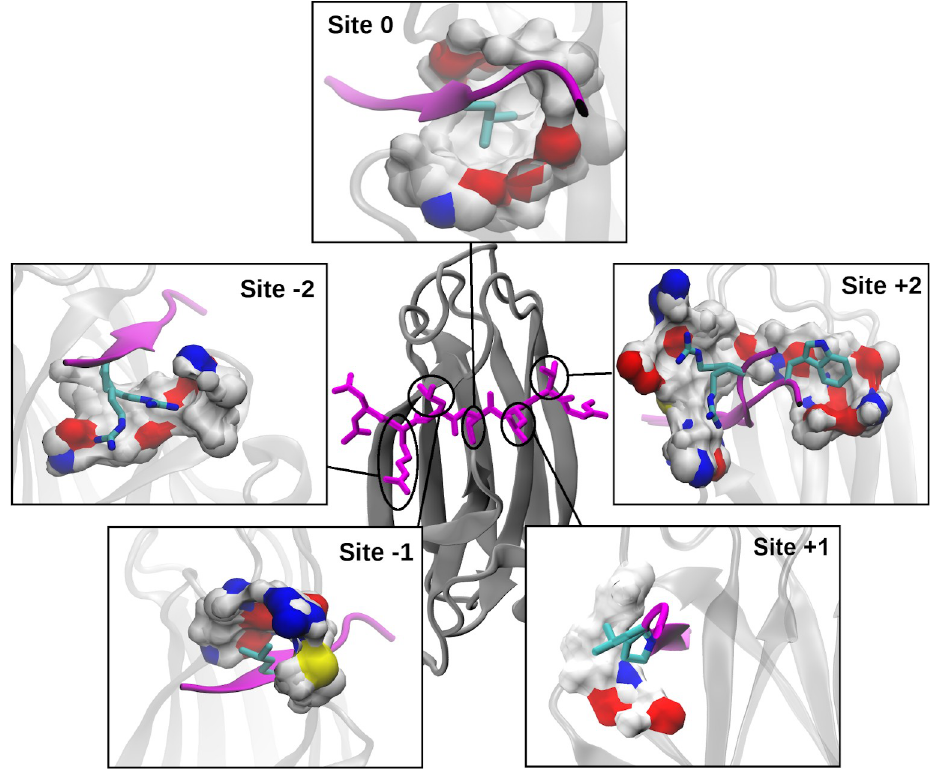
Fig 3. Substrate-interacting sites of DnaK. The center image shows a NRLLLTG substrate (magenta sticks) bound to β SBD (gray cartoon) (PDB: 1DKX). Each zoom-in shows the surface of one of the five binding sites on DnaK, colored by atom type: O (red), N (blue), C/H (white), S (yellow). The side-chain conformations shown were selected to clearly illustrate the extent of each site. These additional side-chain and substrate backbone conformations are taken from: (Site -2) 4JWD, (Site -1) 1DKX, (Site 0) 1DKX (for more viewing angles, see S2 Movie), (Site +1) 1DKZ, 4F00 and (Site +2) 4JWI, 4EZN, 4EZO. The binding site surface was generated using DnaK residues within 5 Å of the substrate side chain(s) at each site, with some atoms excluded for